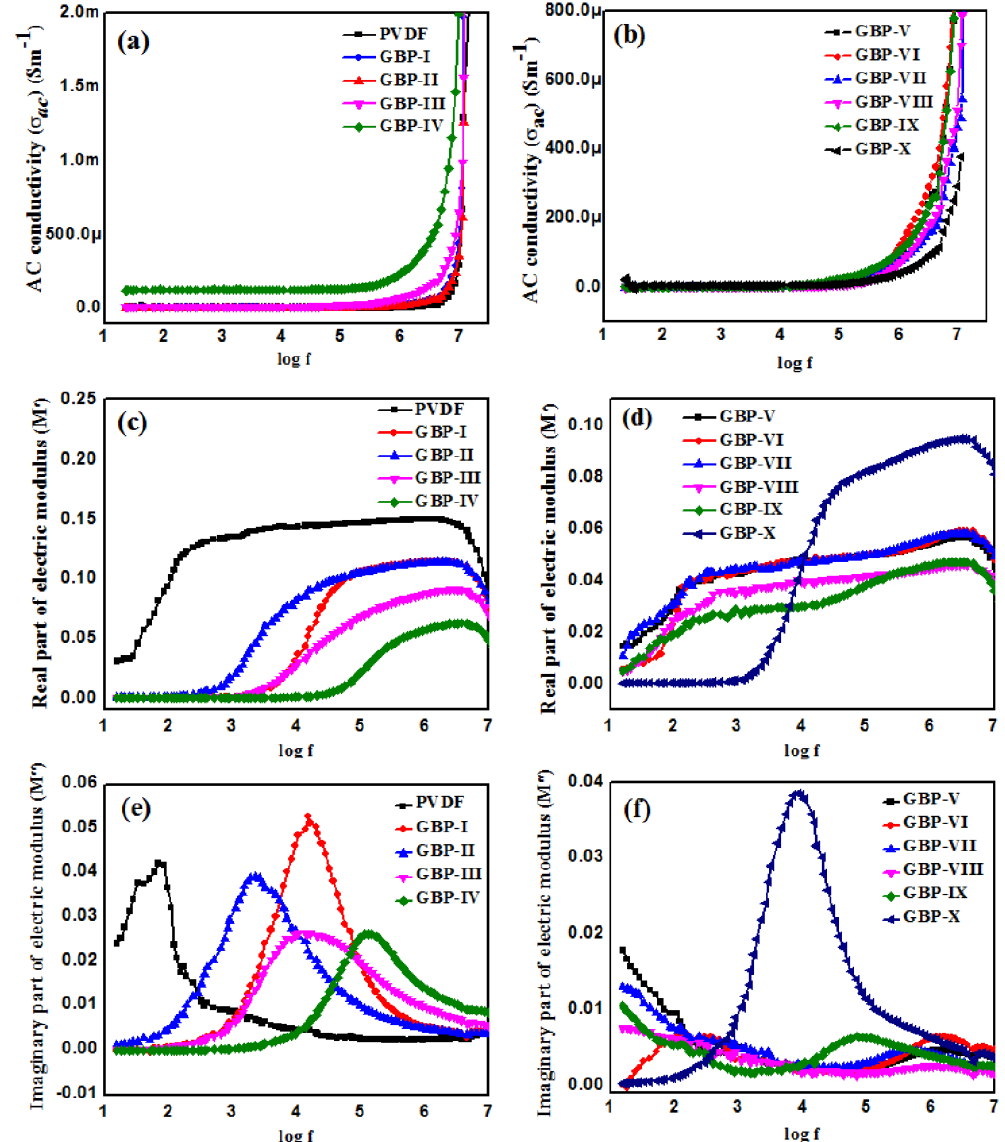
Figure 8. AC conductivity (σ ac ) of ( a ) neat PVDF and G/BT/PVDF nanocomposite films with